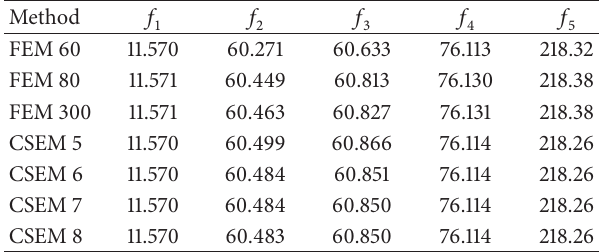
Figure 7: Mode shapes of cabled beam with 5 connections when = 10 6 N/m. 𝑘 𝑙 Table 3: The natural frequencies (Hz) of the cabled beam with tip